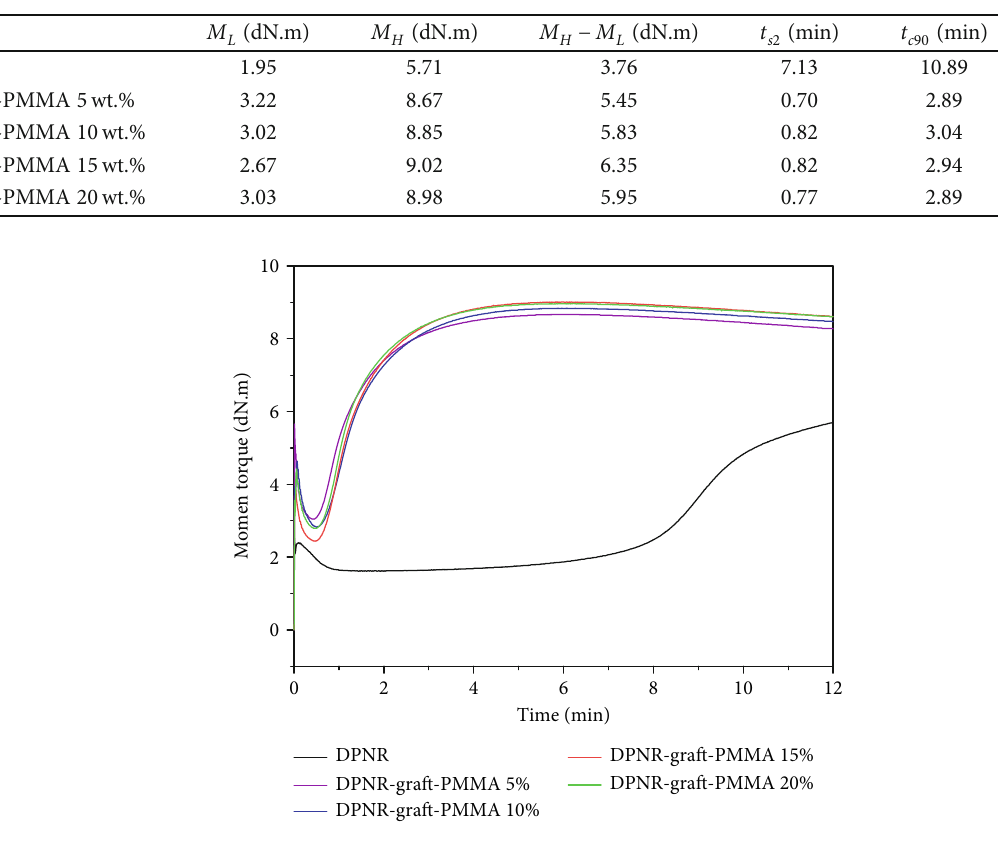
Figure 11: Rheographs for DPNR-graft-PMMA with di ff erent contents of MMA. Table 4: Mechanical properties for vulcanized samples.